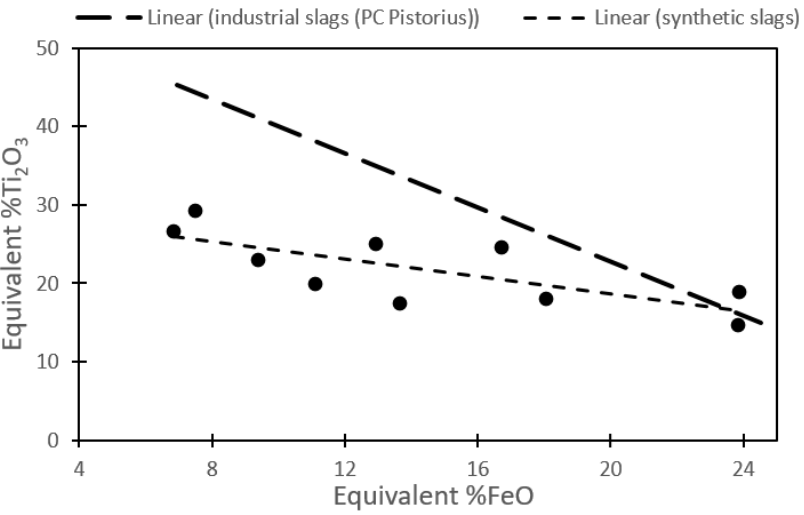
Figure 9. Comparison of an actual trend of ‘equivalent FeO’ and ‘equivalent Ti 2 O 3 ’for slags from Canadian and South African ilmenites (Pistorius, 2002) and the slags prepared synthetically.